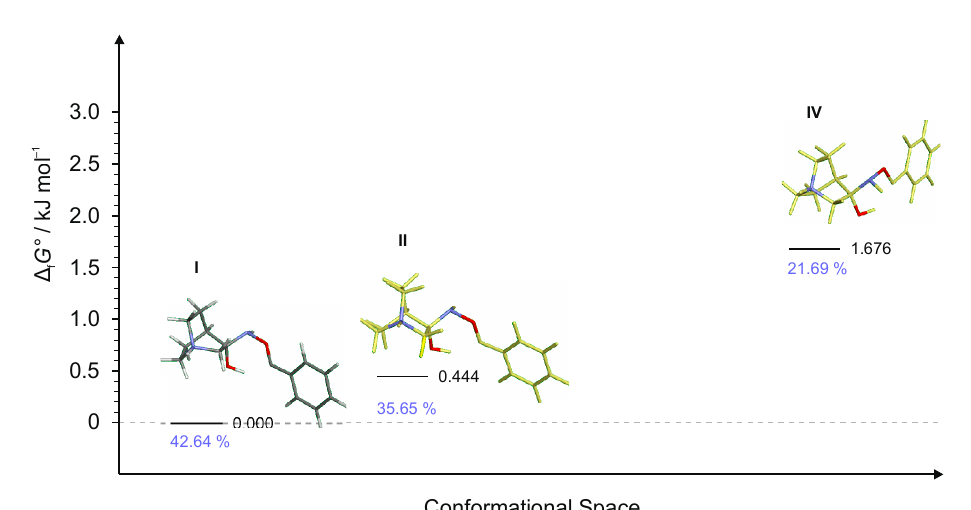
Figure 9. Four lowest energy conformers of RI2 and their relative standards Gibbs energies of for- mation Δ f G °calculated at the B3LYP-D3/6-311++G(d,p) level of the theory. (Relative fractions accord- ing to Boltzmann distribution at 298.15 K are given in blue.)